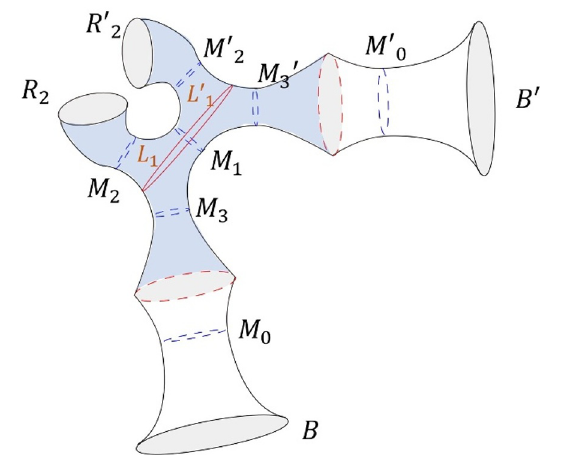
Figure 13 . In late time of the evaporation process, the purple curve L M brane becomes the minimal RT surface homologous to R 1 . After removing the entanglement wedge of R 1 , the brown geodesic L p which has two intersection points on the purple curve is one possible cross section that separates R 2 and B .